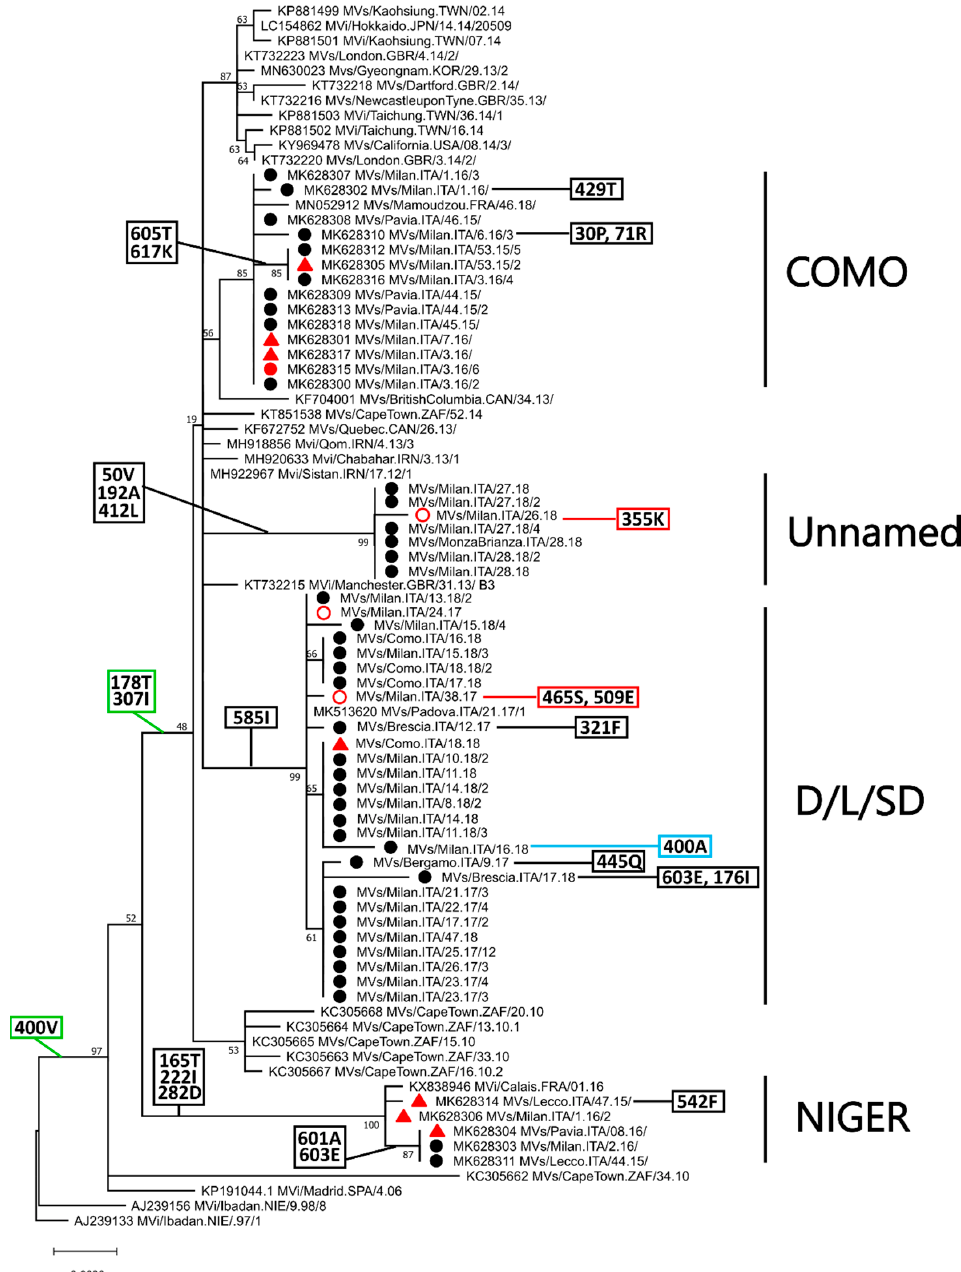
Figure 2. Phylogenetic analysis of genotype B3 H nucleotide sequences belonging to clade B3-400V. The tree was obtained with the maximum-likelihood method [27], based on the Kimura 2 parameters model [28], identified as the best-fitting model after the model test analysis, using MEGA X [29]. A discrete Gamma distribution was used to model evolutionary rate differences among sites (+G = 0.1) and branch support (1000 bootstrap iterations [30]) is provided next to nodes. Other B3 sequences were used as outgroup. Clusters considered in this study are indicated on the right and sequences from Lombardy are indicated by a black circle for non-vaccinated individuals or red shape for vaccinees (triangle: one dose, circle: two doses). Empty circles correspond to partial sequences whose placement was deduced based on a different analysis (Figure S3). Amino acid mutations associated to main branches are indicated in green boxes, those associated to the investigated strains are indicated by black and red boxes for unvaccinated and vaccinated individuals, respectively, while substitutions causing a reversion to the original genotype are in blue.